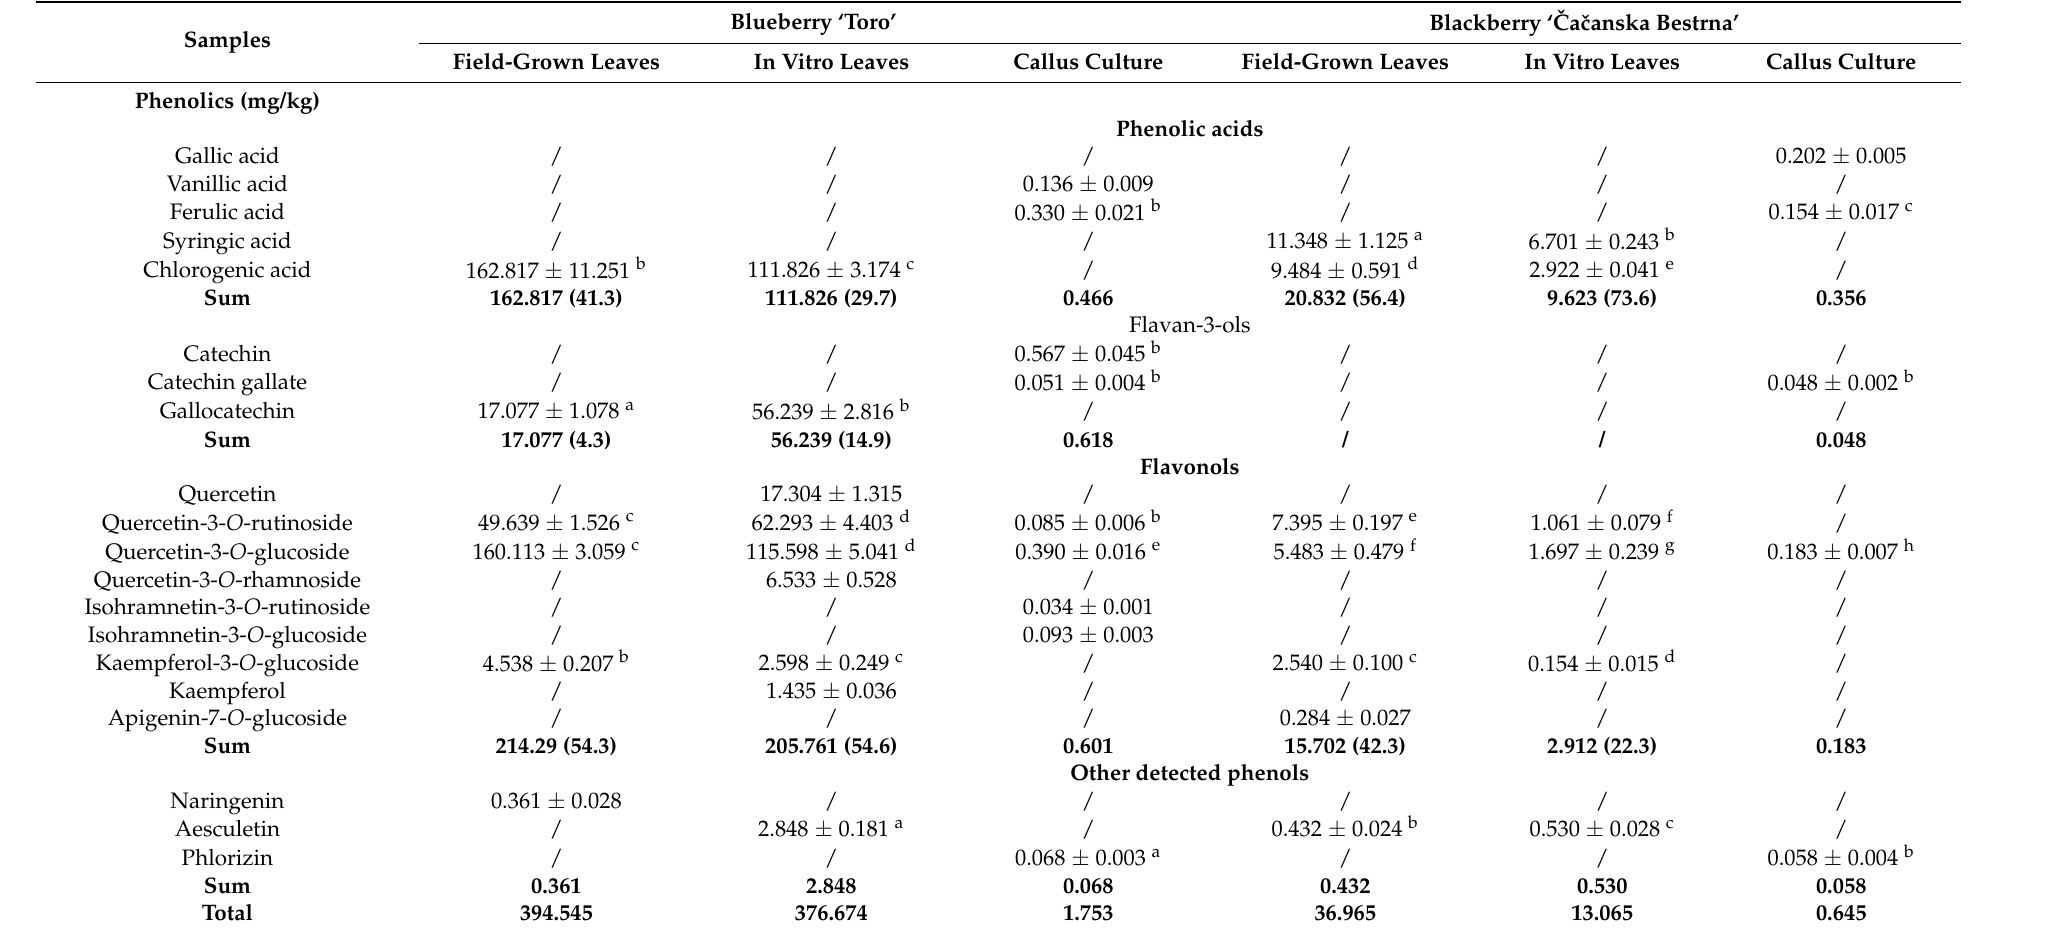
Table 3. The content of phenolic compounds in field-grown and in vitro leaves, as well as in callus cultures of blueberry and